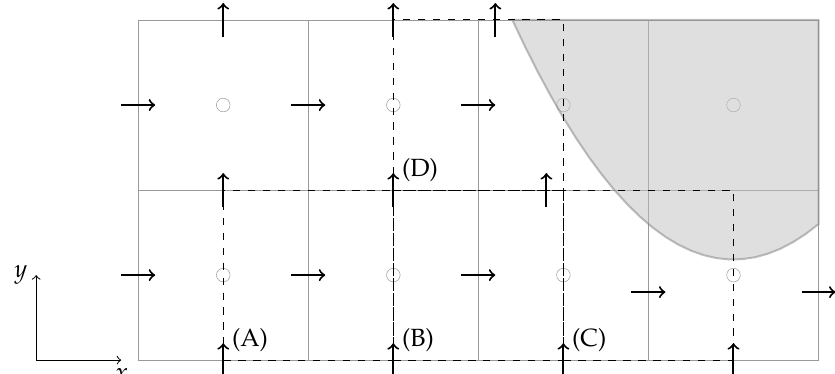
Figure 1. Main grid (solid gray lines) with immersed solid (gray area) showing displaced velocity components and four u -cell types (dashed black lines): (A) and (B) interior cells, (C) and (D) cut cells.